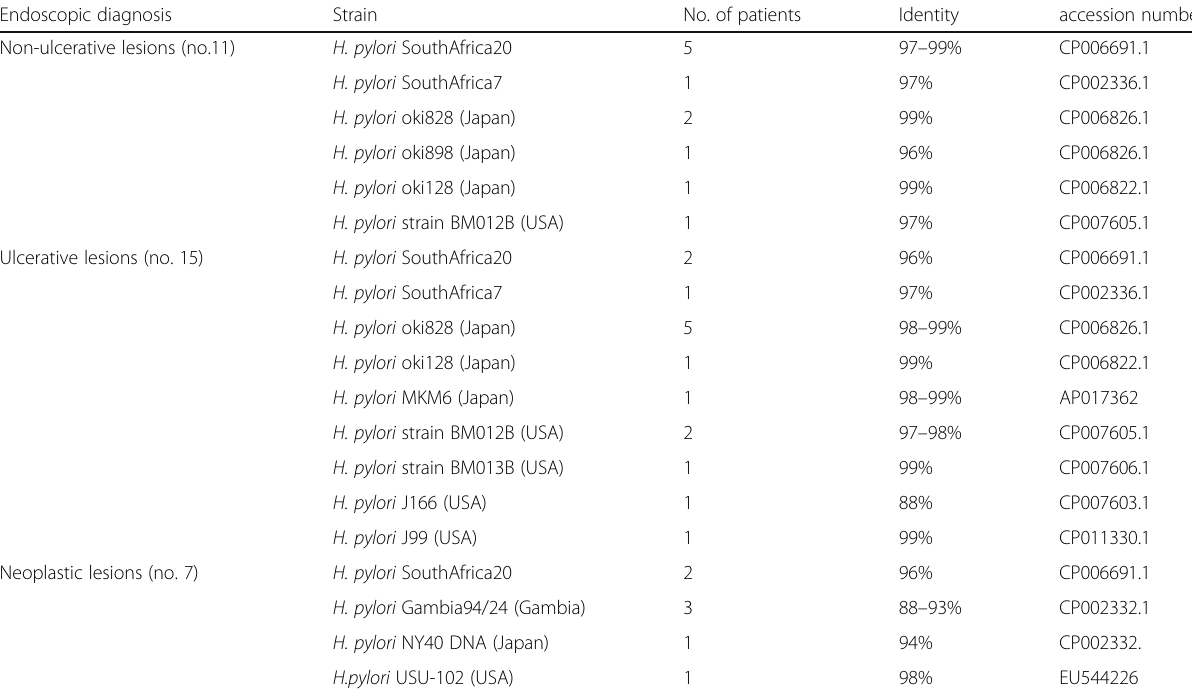
Table 2 Blast results of Egyptian H. pylori 16s rRNA partial sequence with Gene bank nucleotide consensus sequences Endoscopic diagnosis Strain No. of patients Identity Non-ulcerative lesions (no.11)